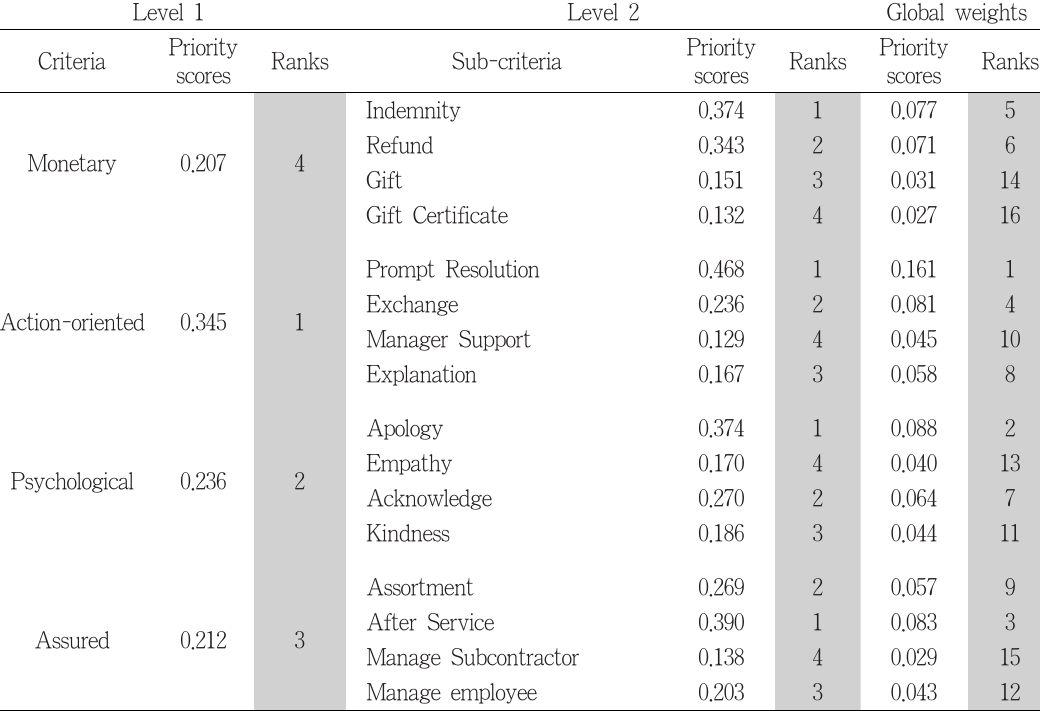
<Table 7> Customers’ Service Recovery Strategy Selection Importance and Priorities